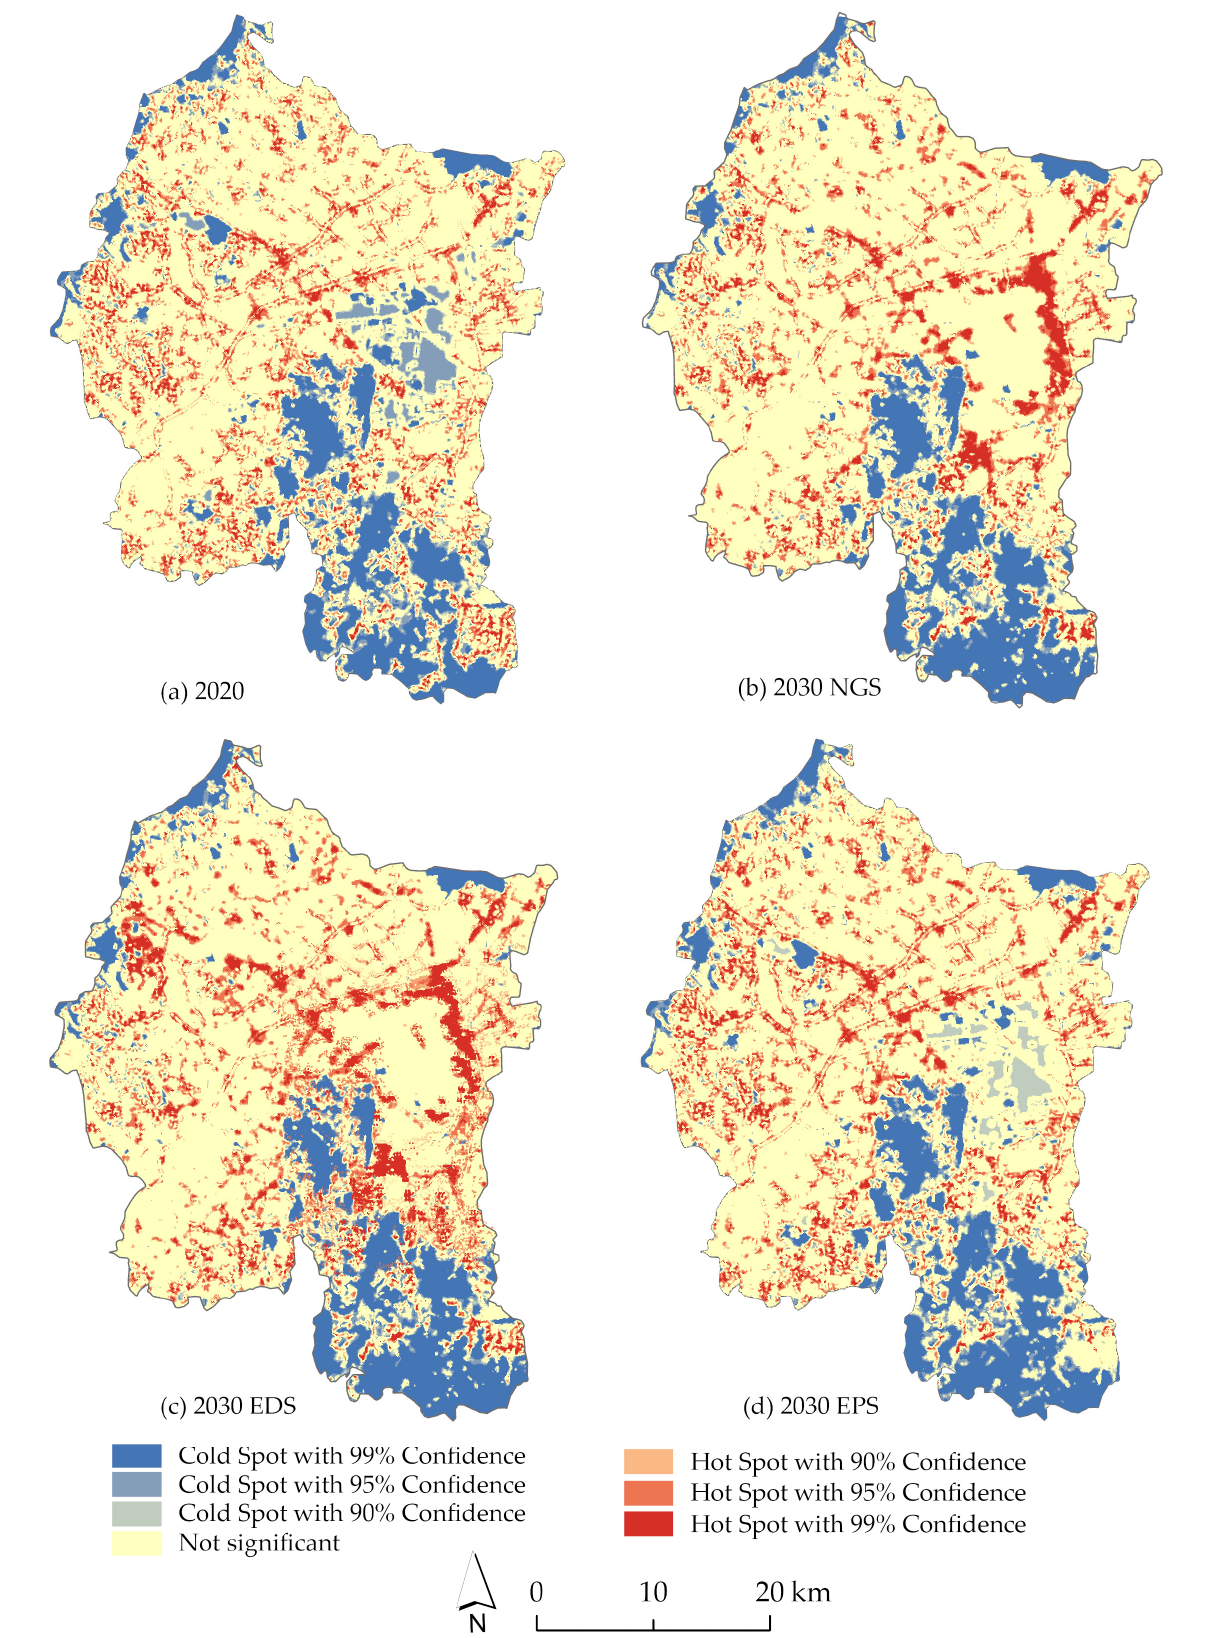
Figure 10. Analysis of local spatial autocorrelation of LUCs.